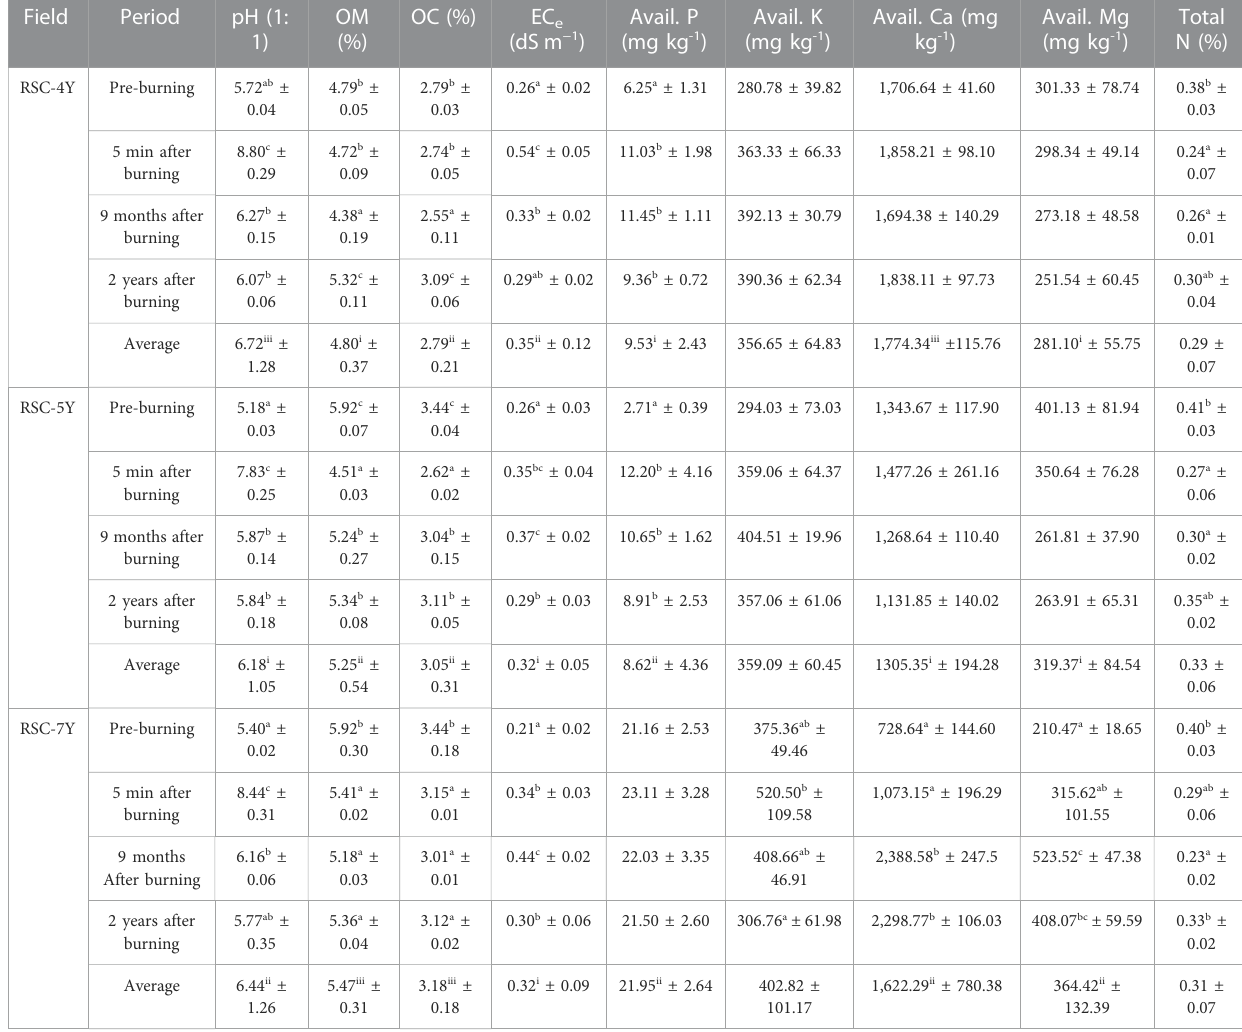
TABLE3Variationsinsoilchemicalproperties:pH;organicmatter(%);organiccarbon(%),EC e (dSm − 1 );availableP,K,Ca,andMg(mgkg − 1 );andtotalnitrogen(%) along the fallow